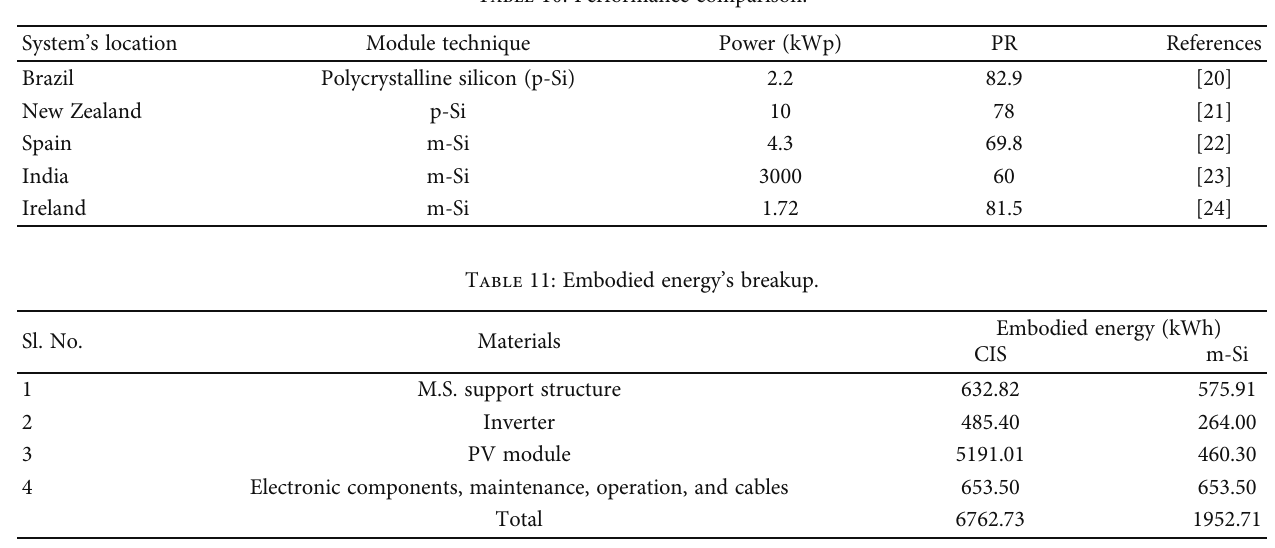
Table 10: Performance comparison.